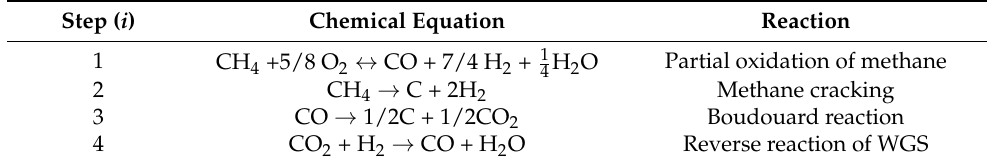
Table 3. Reaction steps of the combined methane reform CRM